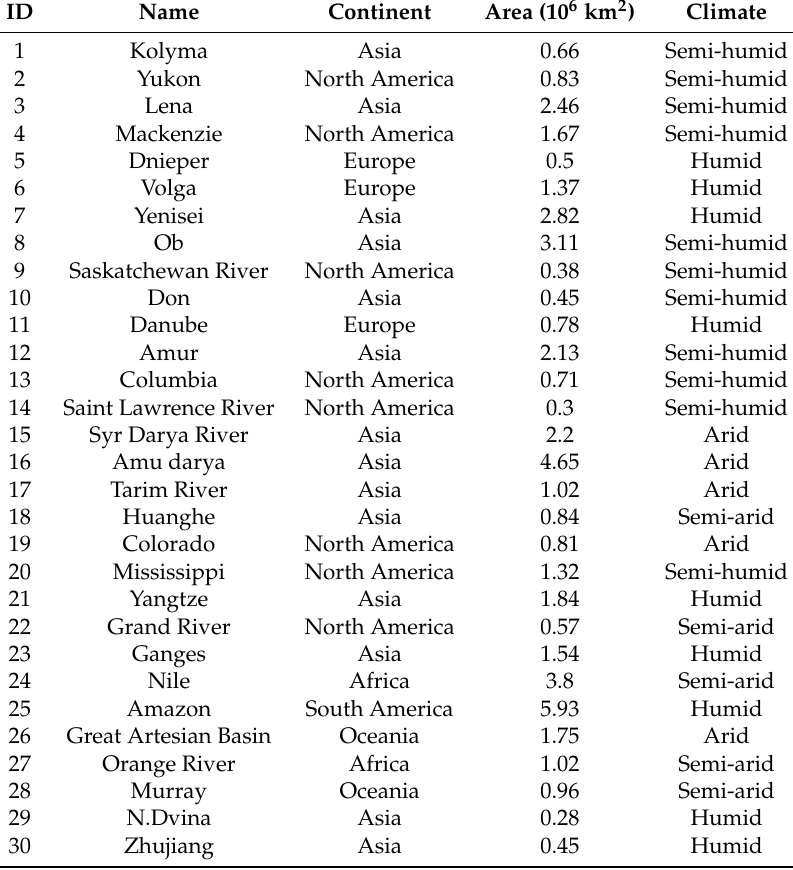
Table 1. Thirty river basins from all over the globe used in this